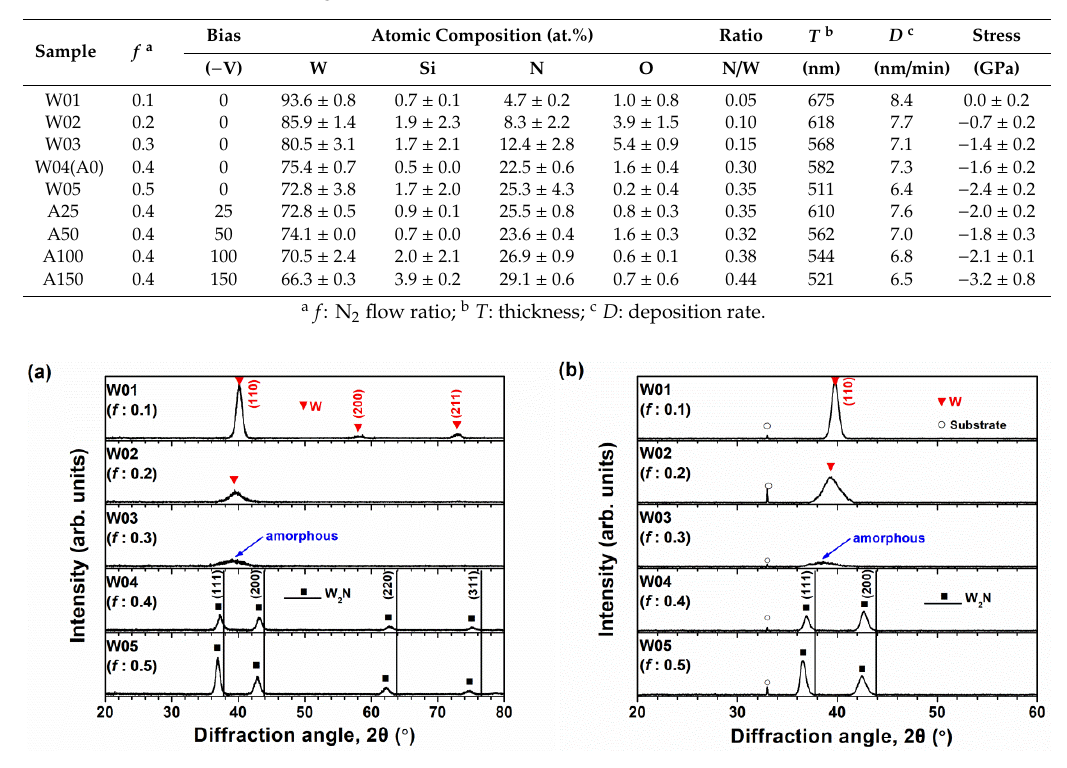
Table 1. Atomic compositions, thicknesses, and residual stresses of W–N films prepared using various N 2 flow ratios and bias